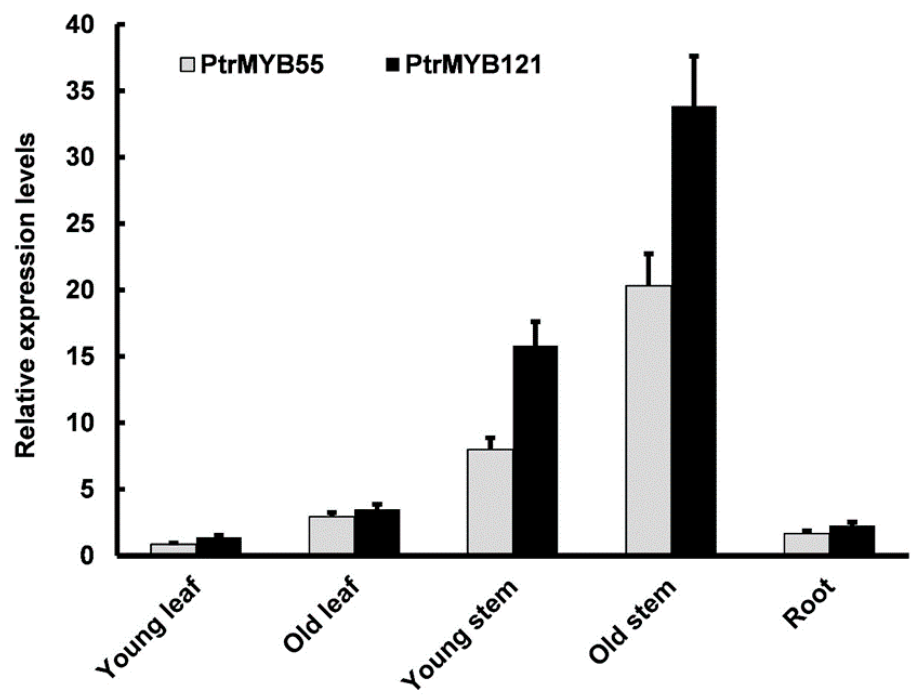
Figure 2. Tissue expression patterns of PtrMYB55 and PtrMYB121 in P. trichocarpa seedlings.